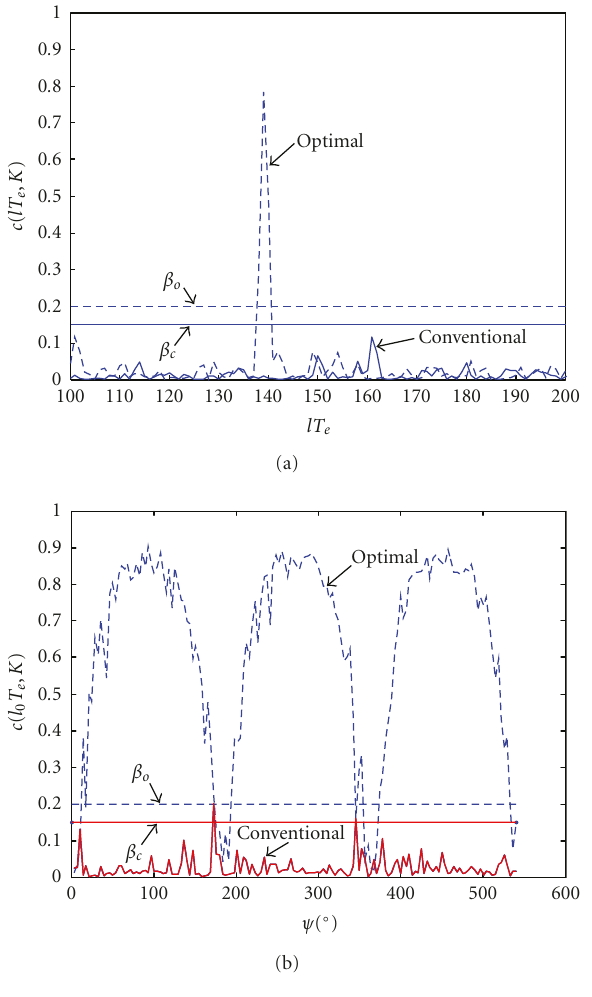
Figure 4: Probability of nondetection of CONV-LS (C) and OPT- Figure 3:Variations of (cid:5) C CONV-LS ( lT e , K ) and (cid:5) C OPT-LS ( lT e , K ) as LS (O) receivers as a function of SNR, K = 64, T = 2 T e , one in- a function of lT e (a), variations of (cid:5) C CONV-LS ( l o T e , K ) and (cid:5) C terference, INR = SNR + 20dB, phase, DOA and delay random, = 64, T = 2 T OPT-LS ( l o T e , K ) as a function of ψ (b), K e , one inter- FAR = 0 . 001, 100 000 realizations, BPSK and N = 1,2,3,4 (a), MSK ference, N = 1, π s /η 2 = 5dB, INR = 20 dB, ψ = π/ 4, FAR = 0 . 001. (M), GMSK (G), N = 1, L = 1,3